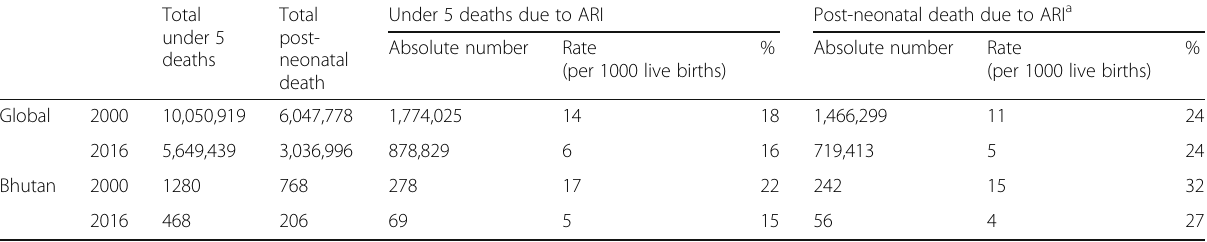
(per 1000 live births)